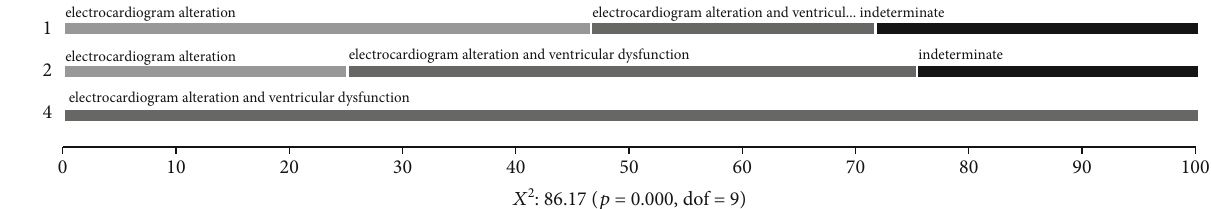
Figure 1: CCD patients ’ clinical data analysis. Frequency of patients by the stage of cardiac burden in relation to the NYHA functional classi fi cation.